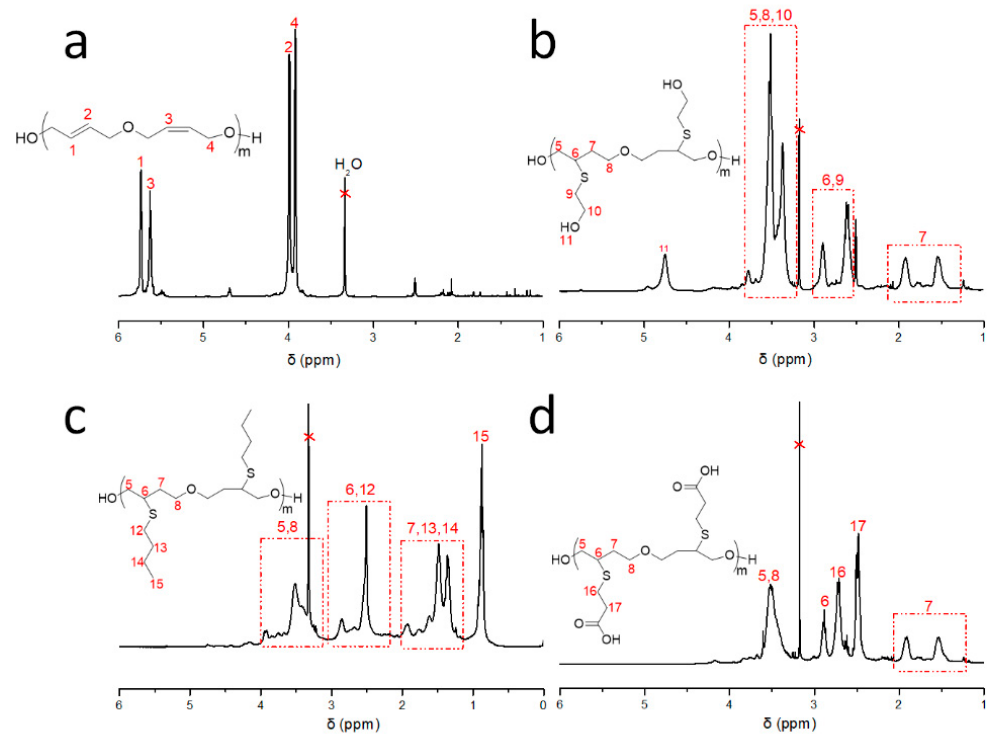
Figure 2. 1 H NMR spectra of UPTHF (( a ), Sample 2 in Table 1), PTHF OH ( b ), PTHF but ( c ) and PTHF acid ( d ) in DMSO- d 6.